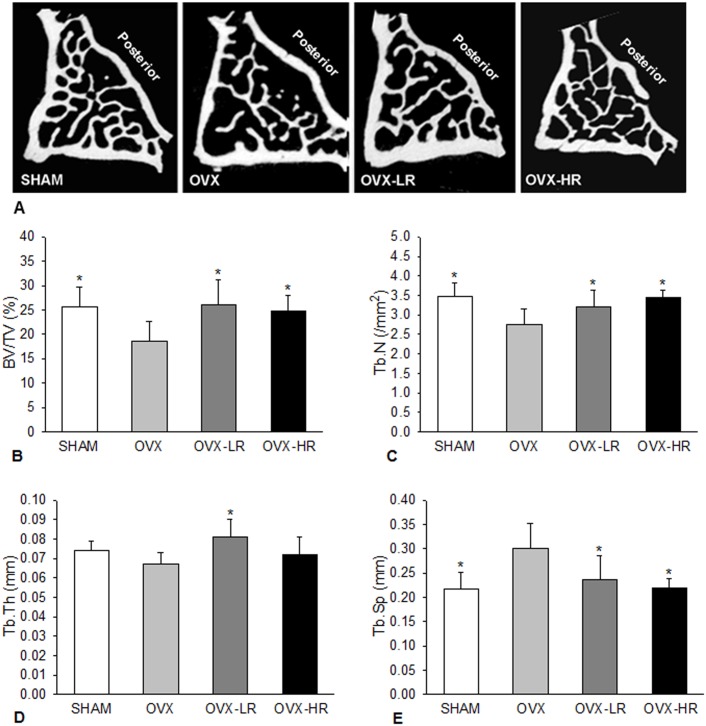
Low-dose RIS preserves cancellous bone structure as good as high-dose RIS in OVX rats.A) 2D micro-CT images of the first lumber vertebra from different groups; B-E) Comparison of bone volume (BV/TV)(B), trabecular number (Tb.N)) (C), trabecular thickness (Tb.Th)) (D) and trabecular separation (Tb.Sp)(E), respectively, among SHAM, OVX, OVX-LR and OVX-HR groups. *p < 0.05 versus OVX group. Numerical data are presented in supporting information (S3 Table).